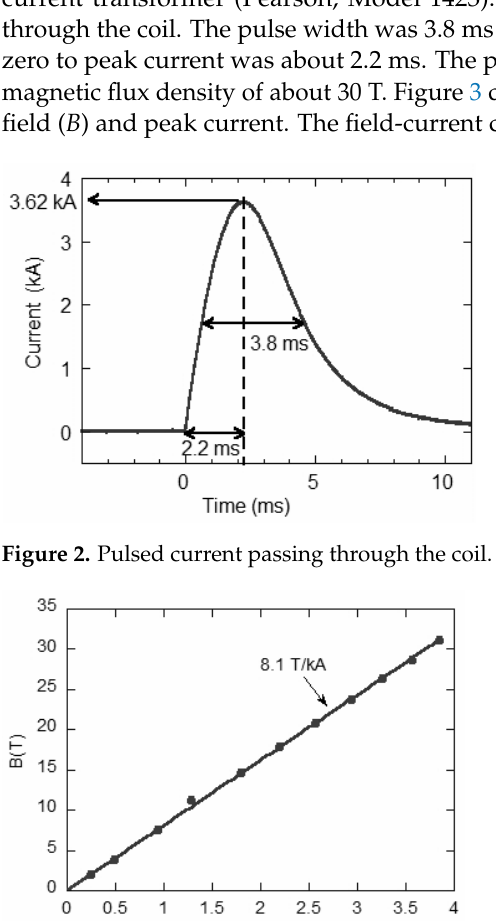
Figure 3. Relationship between magnetic field ( B ) and peak